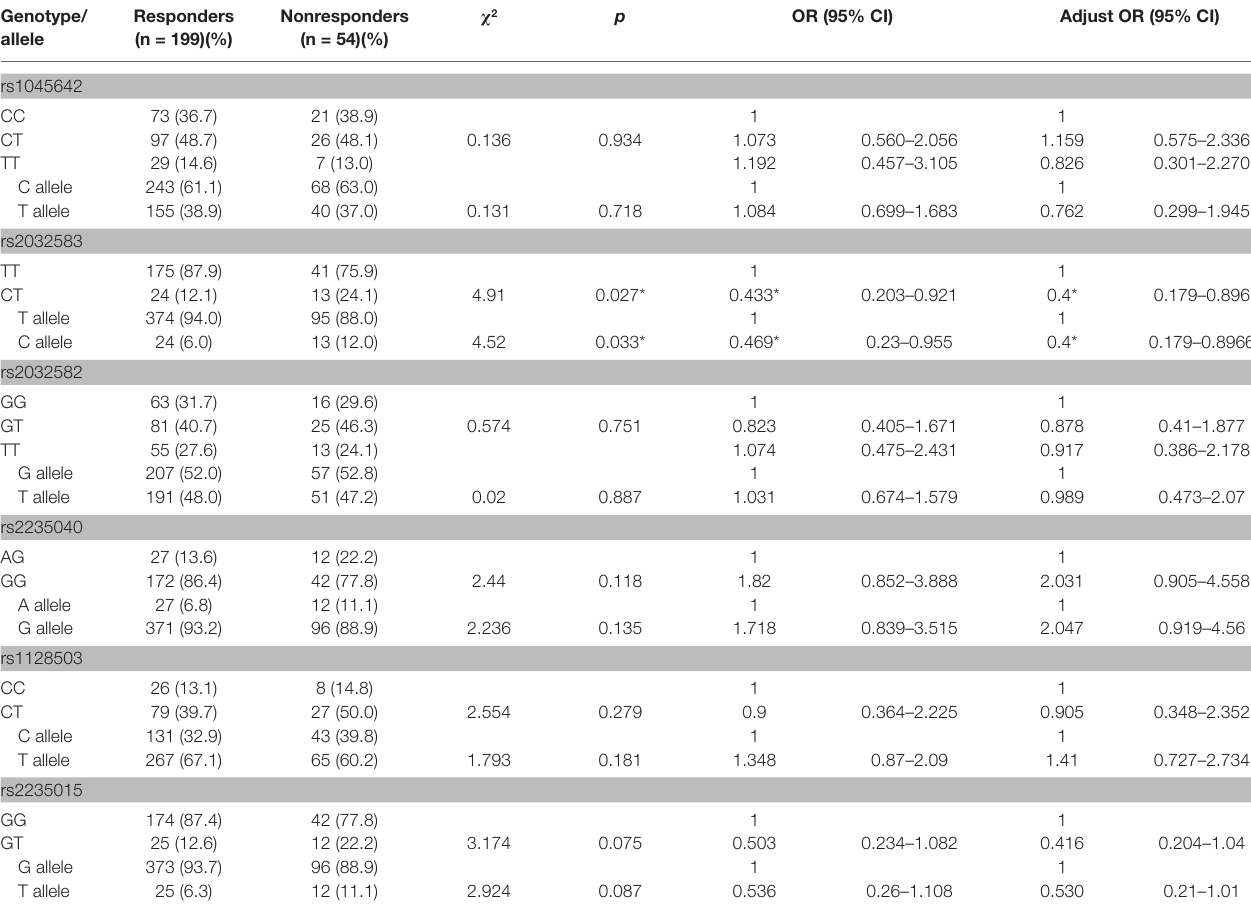
TABLE 3 | Genotype and allele frequencies of six SNPs of the ABCB1 gene in the nonresponders and the responders. Genotype/